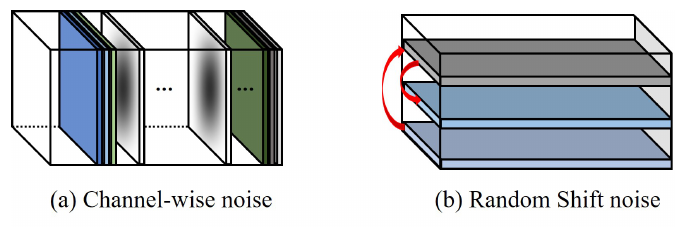
Figure 3. Proposed two structure noises: ( a ) channel-wise noise, which consists of randomly selected channels multiplied by the inverse–cosine window, and ( b ) random shift noise, which consists of randomly shuffled